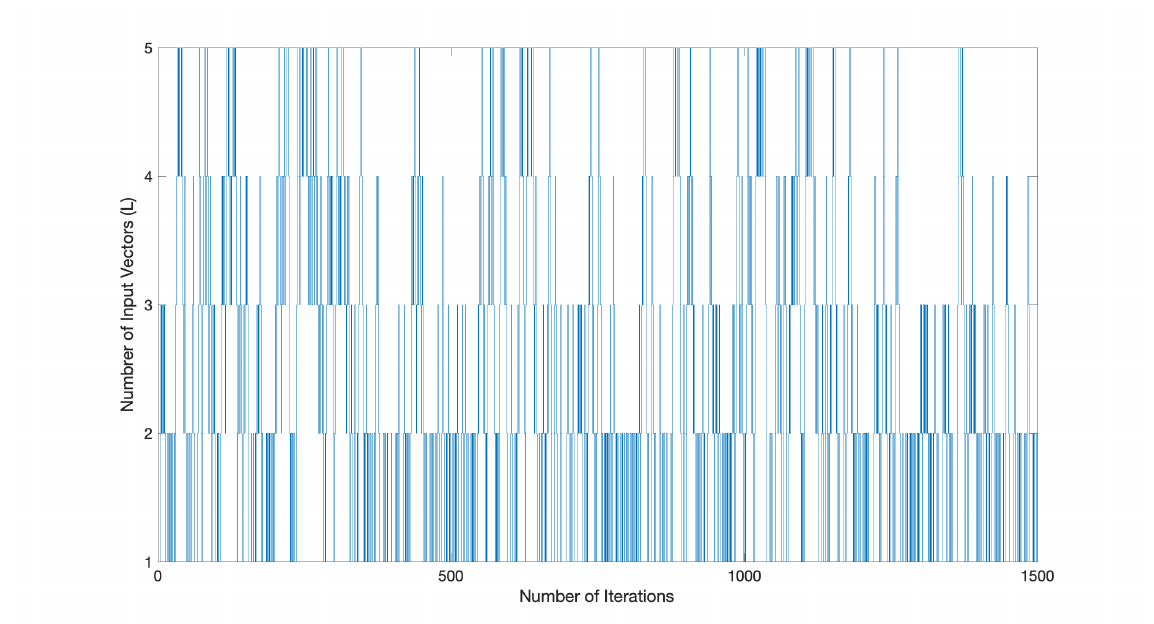
Figure 8. Zoomed view of the number of input vectors for case